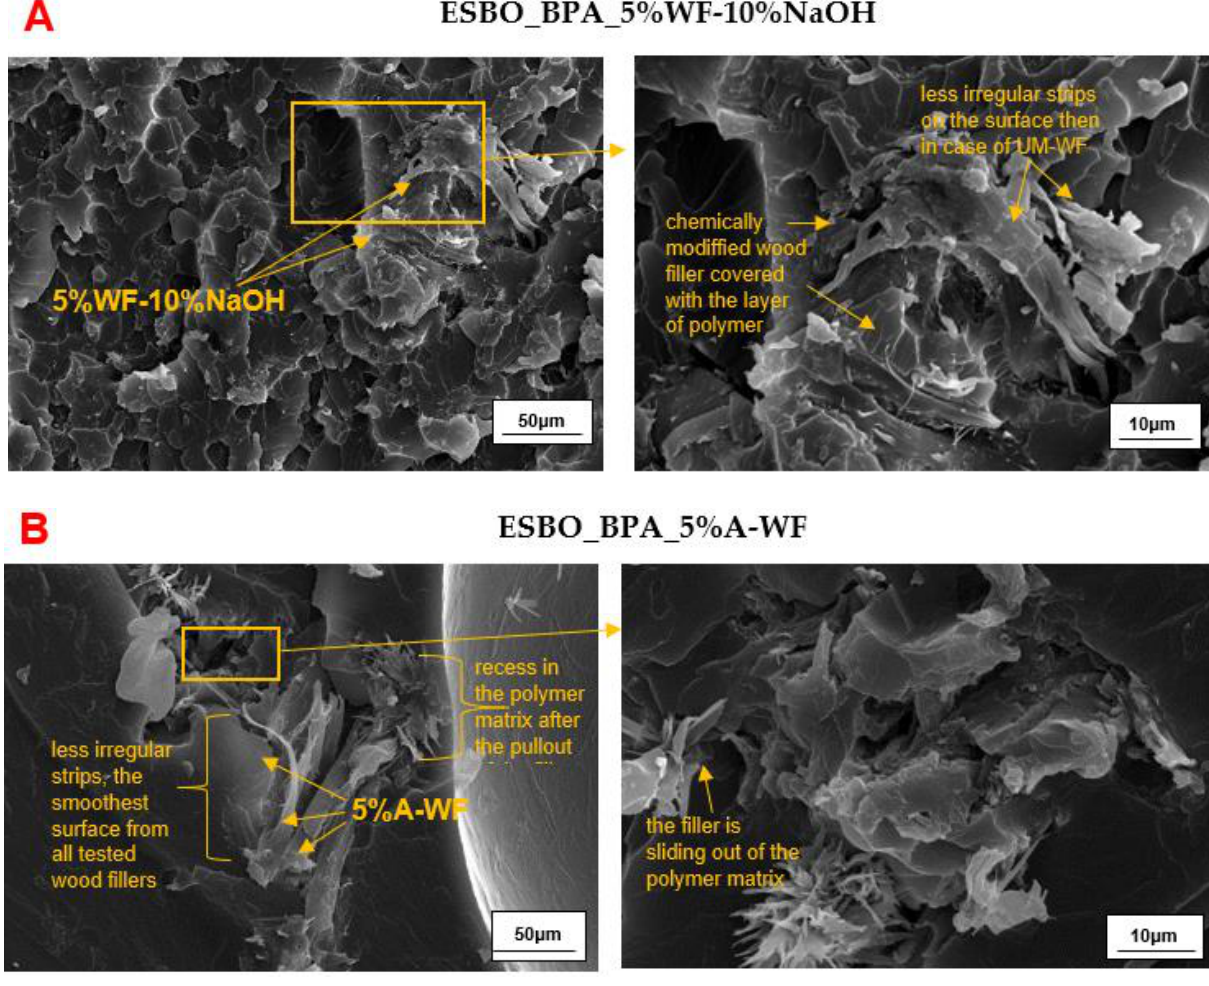
Figure 10. SEM micrographs of the impact fracture surfaces of the crosslinked samples of ( A ) ESBO_BPA composition filled with 5 wt % of wood flour mercerized using a 10% solution of NaOH and ( B ) ESBO_BPA composition filled with 5 wt % of acetylated wood flour.